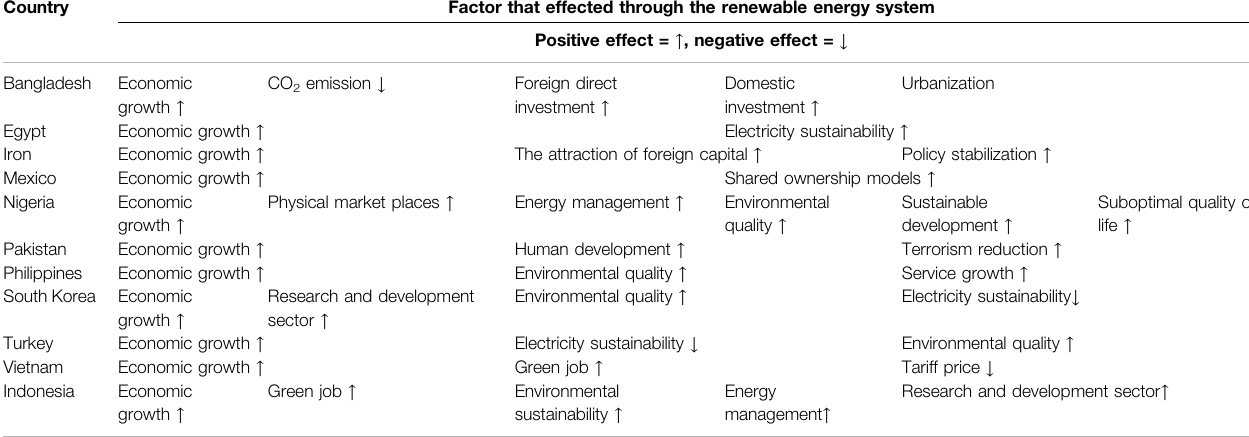
TABLE 7 | Factor that effected through the renewable energy system on N-11 countries. Country